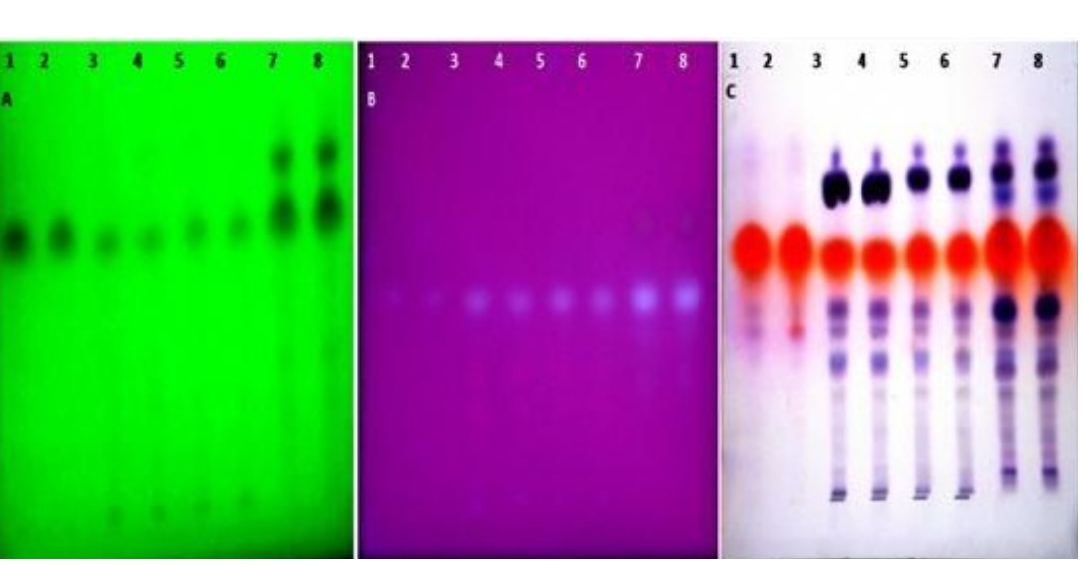
Figure 2. HPTLC fingerprint of different essential oils of seeds of T. ammi L. extracted using different extraction techniques (track 1–2: Hydrodistilled oil, 3–4: Solvent extracted oil, 5–6: Ultra sonication oil, 7–8: SC-CO 2 oil) observed at ( A ) 254 nm, ( B ) 366 nm, ( C ) In daylight after derivatization by using